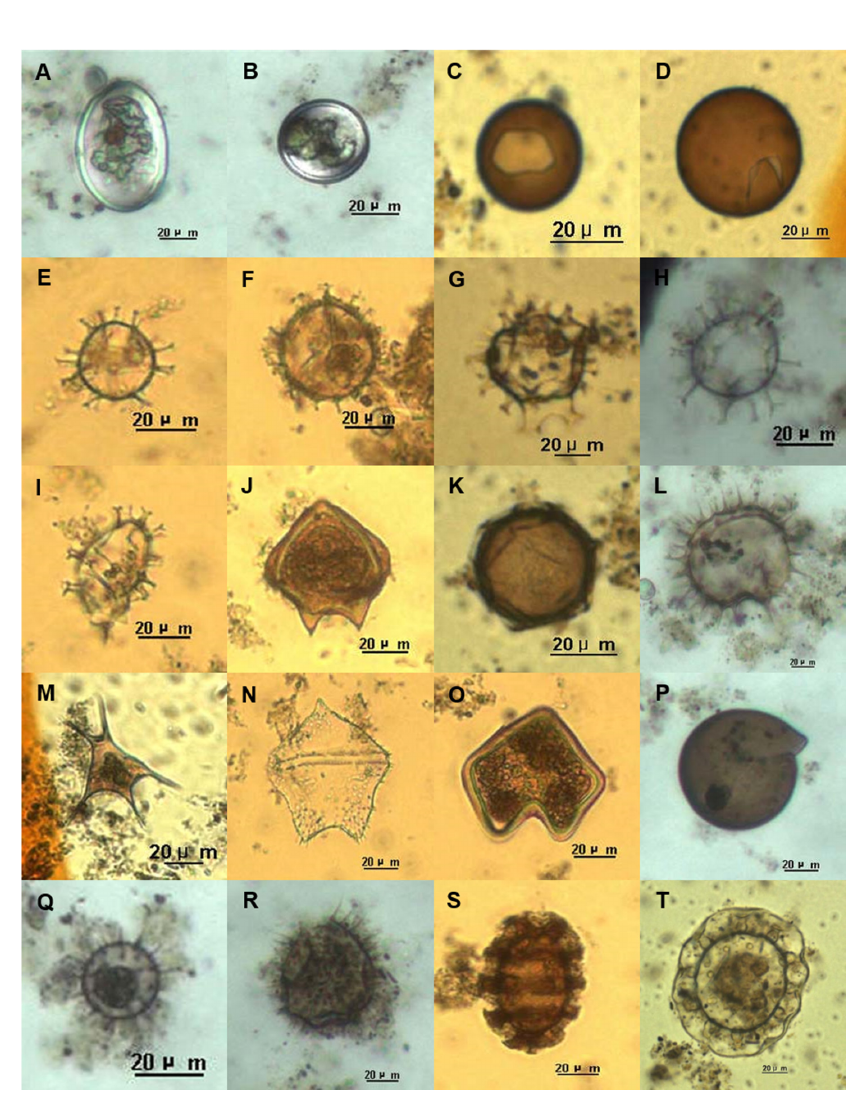
Figure 5. Photographs of dinoflagllate cysts found in the surface sediments adjacent from aquaculture fish farms in Tongyeong Snyang-eup, Southern coastal waters of Korea. ( A ). Alexandrium tamarense/catenella, ( B ). Alexandrium affine, ( C ). Brigantedinium caracoense, ( D ). Brigantedinium sp., ( E ). Spiniferites bulloides, ( F ). Spiniferites bentori, ( G ). Spiniferites membranaceus, ( H ). Spiniferites ramosus, ( I ). Spiniferites sp., ( J ). Quinquecuspis concretum, ( K ). Protoperidinium americanum, ( L ). Selenopemphix quanta, ( M ). Stelladinium reidii, ( N ). Trinovantedinium applanatum, ( O ). Votadinium carvum, ( P ). Gymnodinium catenatum, ( Q ). Oblea acantocysta, ( R ). Polykrikos hartmannii, ( S ). Polykrikos kofoiddi/schwartzii complex, ( T ). Tuberculodinium vacampoe.